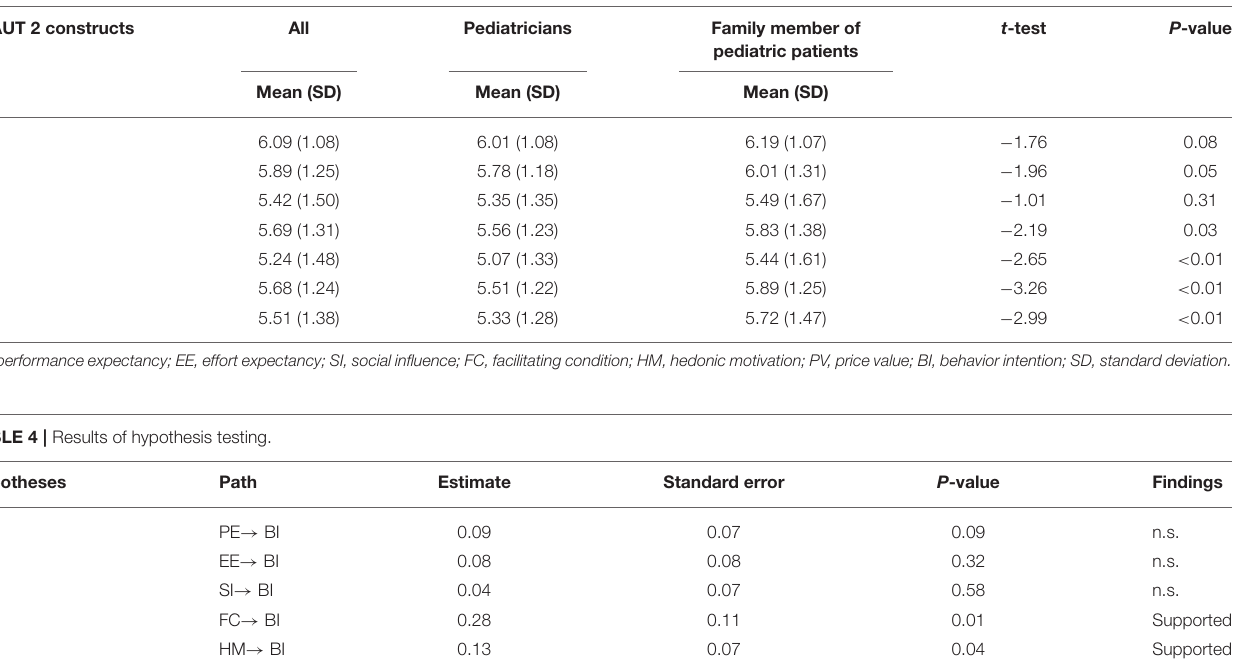
TABLE 3 | Perception of telemedicine services by pediatricians and family members of patients.